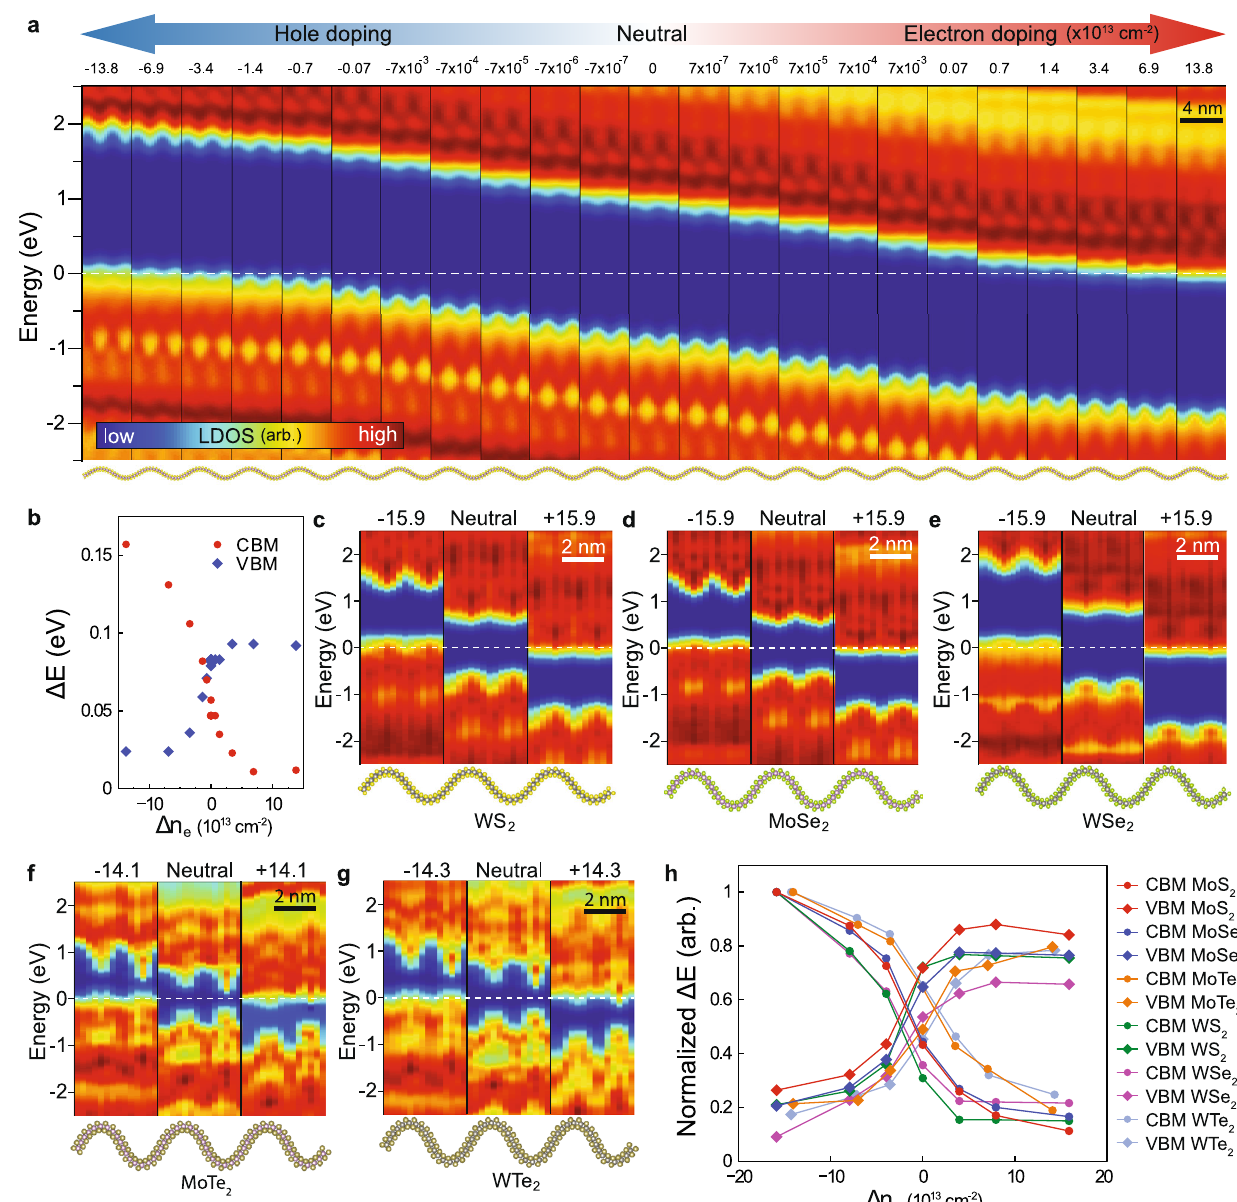
Fig. 2 | DFT calculations showing a spatial fl attening of band edges in various 2D semiconductors. a The variation of the LDOS depending on the doping con- centration of monolayer MoS 2 in cylindrical curvature structure. Corresponding atomic structure is shown under each column. Blue regions in LDOS indicate band gap. The Fermi level is set to zero (white-dashed line). Colored arrows at the top indicate the doping levels of each column. b Fluctuation range of band edges ( Δ E ) asafunctionofdopingconcentration( Δ n e )extractedfromthetheoreticalresultsin